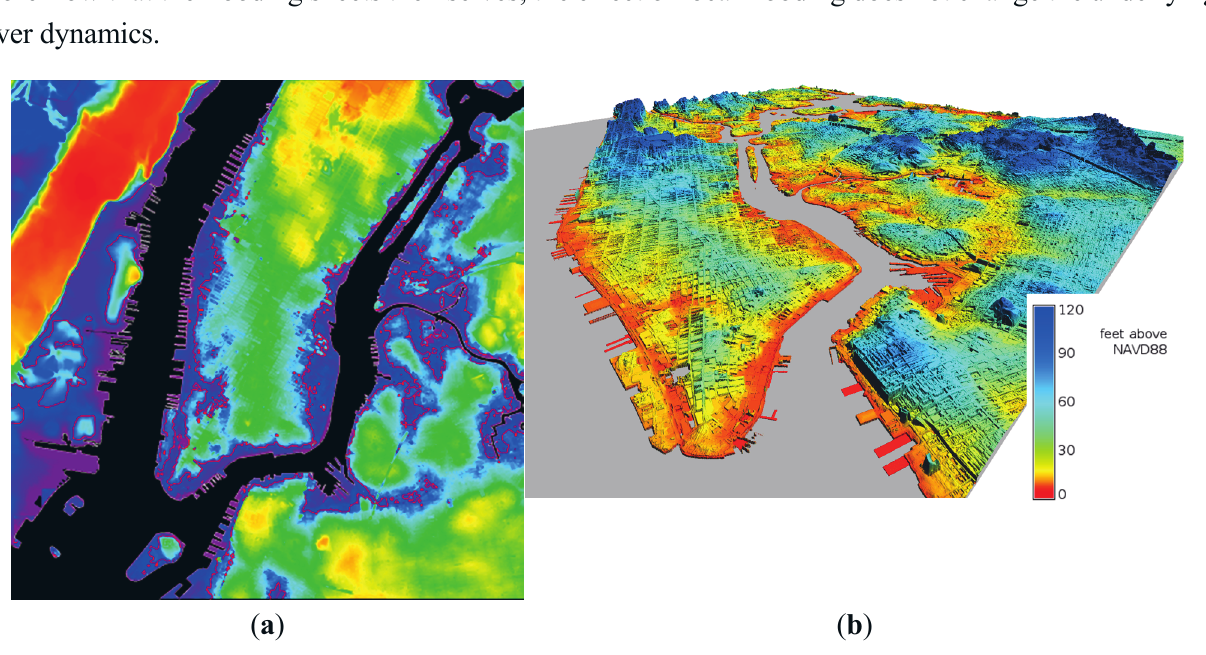
Figure 6. ( a ) 5-level ADCIRC w/SWAN-predicted Sandy inundation of central NYC and northern NJ during Sandy (colored blue), obtained with EnKF Control run, 2D ADCIRC, SWAN- and LIDAR- accurate topography; ( b ) Isometric projection of LIDAR-based 5-level ADCIRC w/SWAN-simulated flooding of the boroughs of Manhattan, Queens and Brooklyn (red and orange